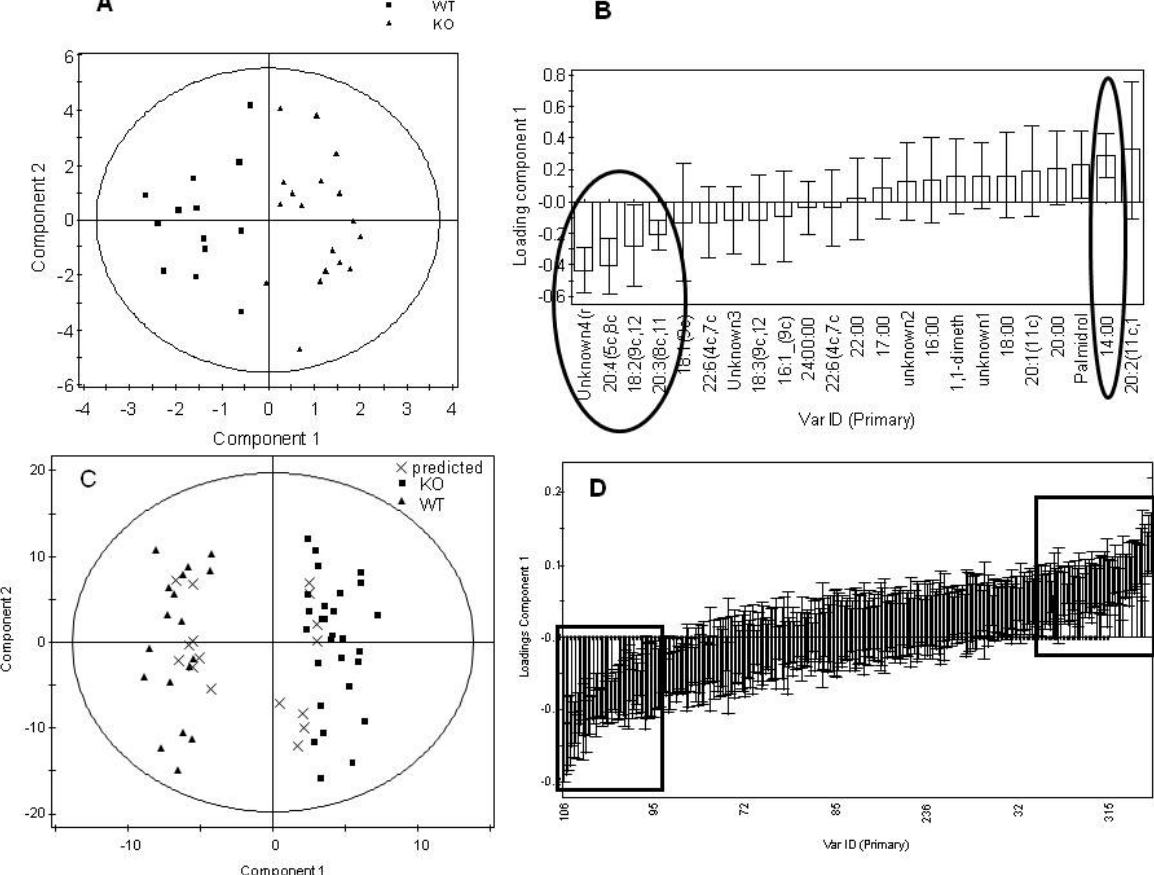
Figure 4. Summary plots for the multivariate analysis of the lipid fraction for the total dataset comparing genotype, regardless of gender. Analysis of organic GC-MS